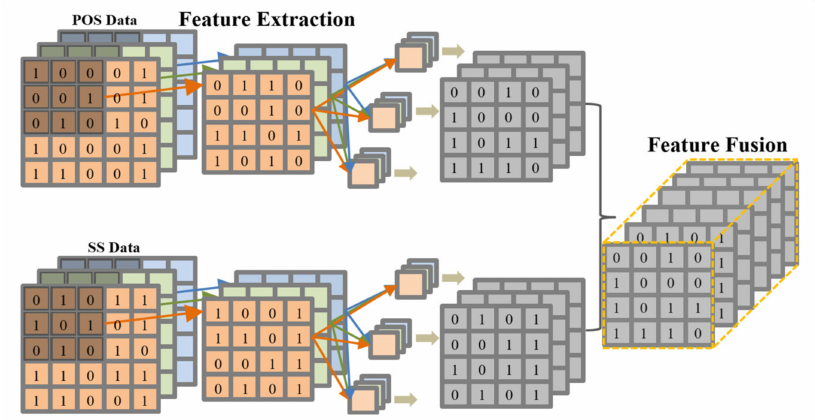
Figure 10. The feature extraction and fusion layer.